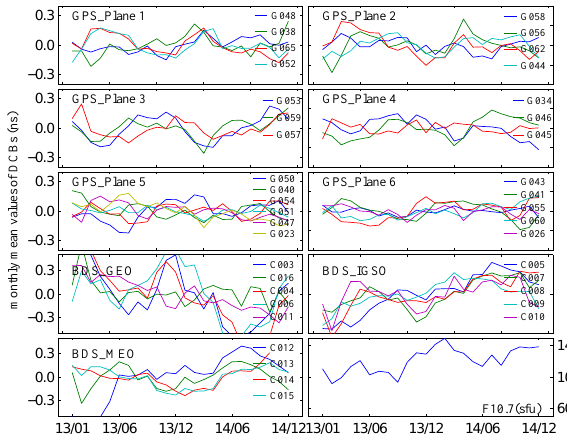
Figure 7. The variation in monthly mean values of GPS + BDS satellites DCBs. Here the 2-year mean values for individual satel- lites are removed for comparison. The bottom-right panel is the monthly variation in F10.7cm solar flux provided by Natural Re- sources Canada